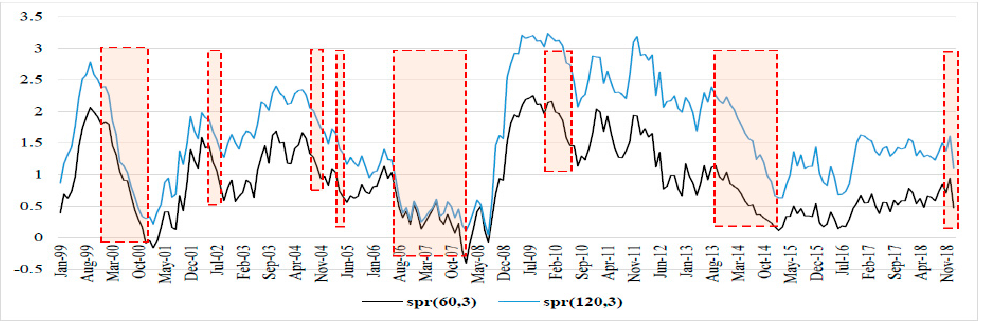
Figure 2. Yield spread-France.